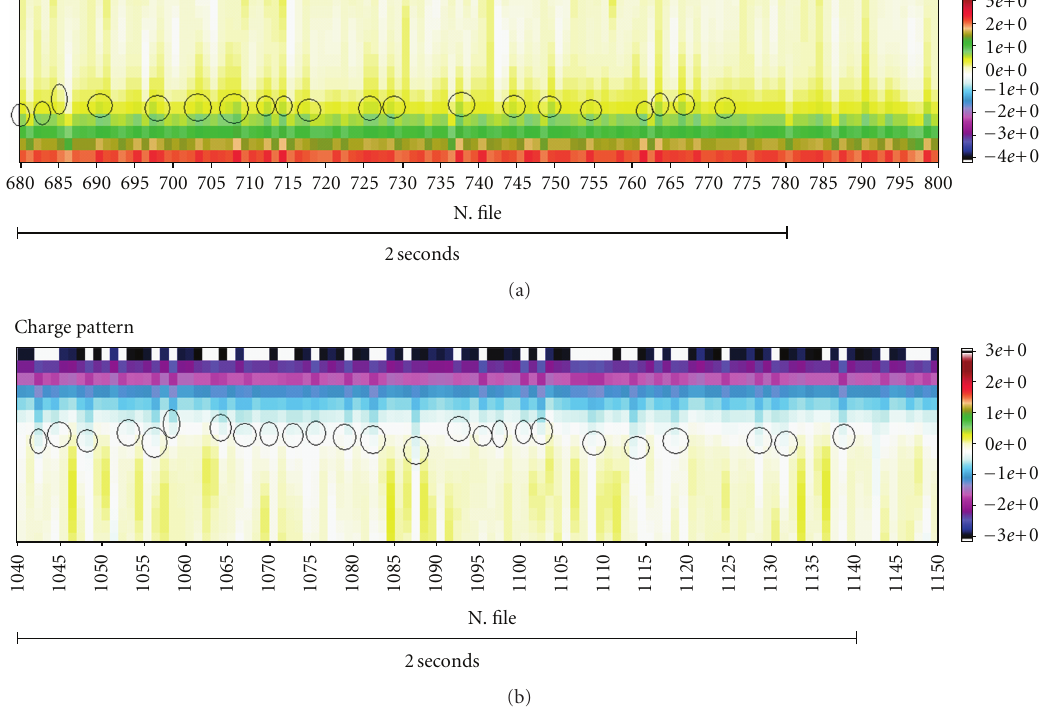
Figure 13: Enlargement of the charge pattern in specimen no. 0 (Figure 1(a)) positive (a) and negative (b) charge pulses are labeled by circles.